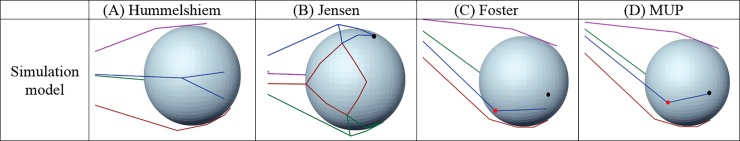
Simulation of the various muscle transposition procedure.(A) Hummelsheim, (B) Jensen, (C) Foster, (D) muscle union procedure (MUP) (blue line: superior rectus, green line: inferior rectus, red line: lateral rectus, purple line: medial rectus, red dot: pulley, black dot: original insertion of the superior rectus muscle). We changed muscle vectors, origins, and pulley locations consistent with each surgical method to realize the surgical effect and then evaluated temporal rotation degree of the eyeball using each biochemical model.